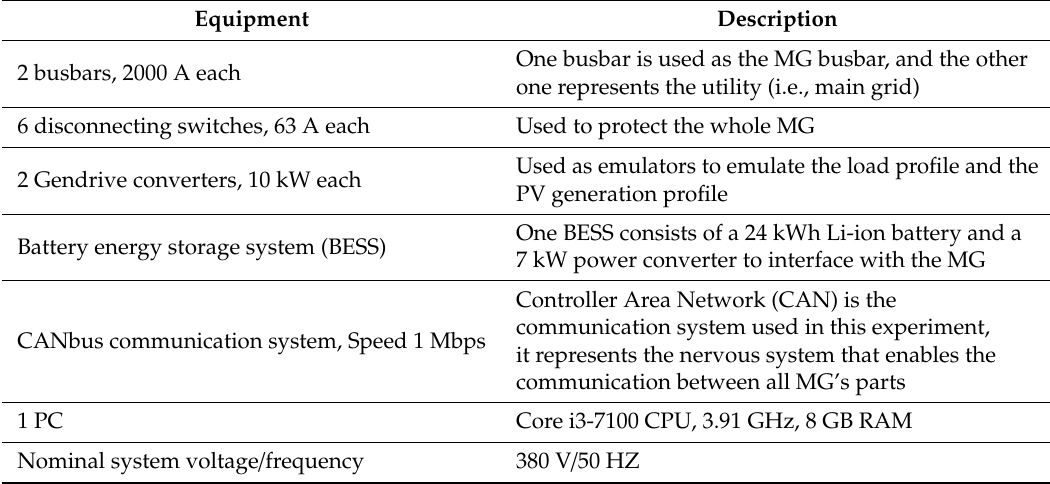
Table A1. Components of the MG used in this